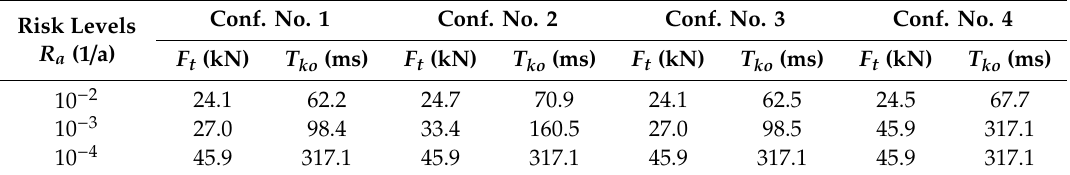
Table 4. Values of force F t and time T ko for defined risk levels and di ff erent PSPA configurations under short circuit conditions at lookout point A.